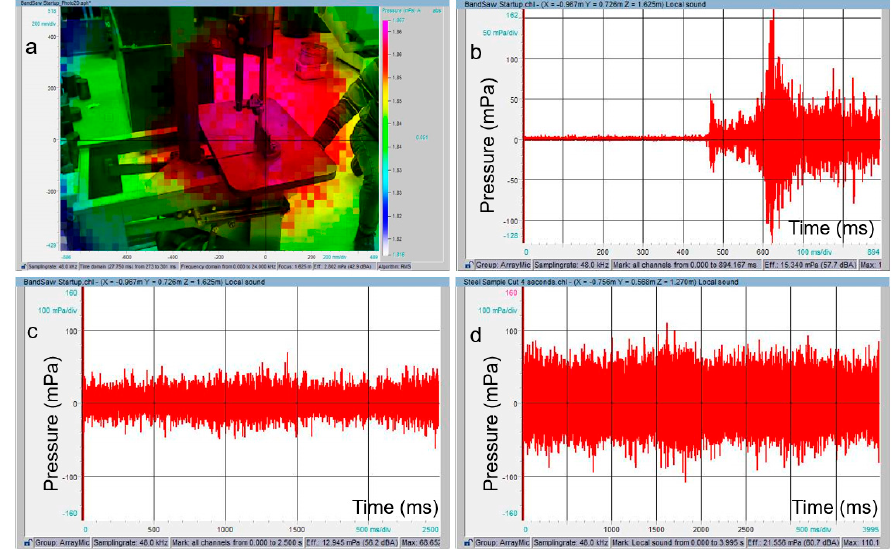
Figure 5. Acoustic emission for vertical band saw: ( a ) 2D image superimposed with noise mapping intensity; ( b ) noise emission during startup; ( c ) noise emission during idle speed; and ( d ) noise emission during load.